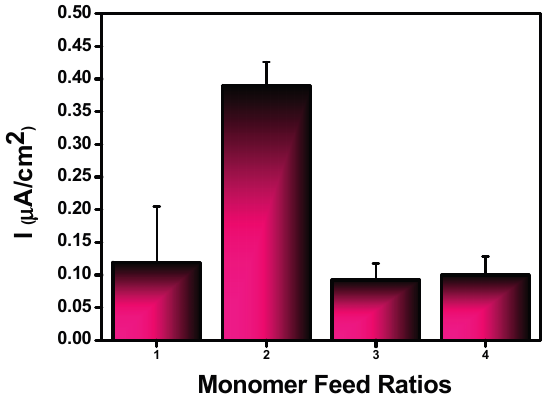
Figure 5. Effect of monomer feed ratio on the biosensor response (SNS-NH 2 /SNS-NH 2 -Fc ratios: (1): 0.5/4.5 mg; (2): 1.0/4.0 mg; (3): 2.0/3.0 mg and (4): 5.0/5.0 mg: in sodium acetate buffer, 50 mM, pH 4.5, +0.45 V, [Glucose]: 5.0 mM). Error bars show standard